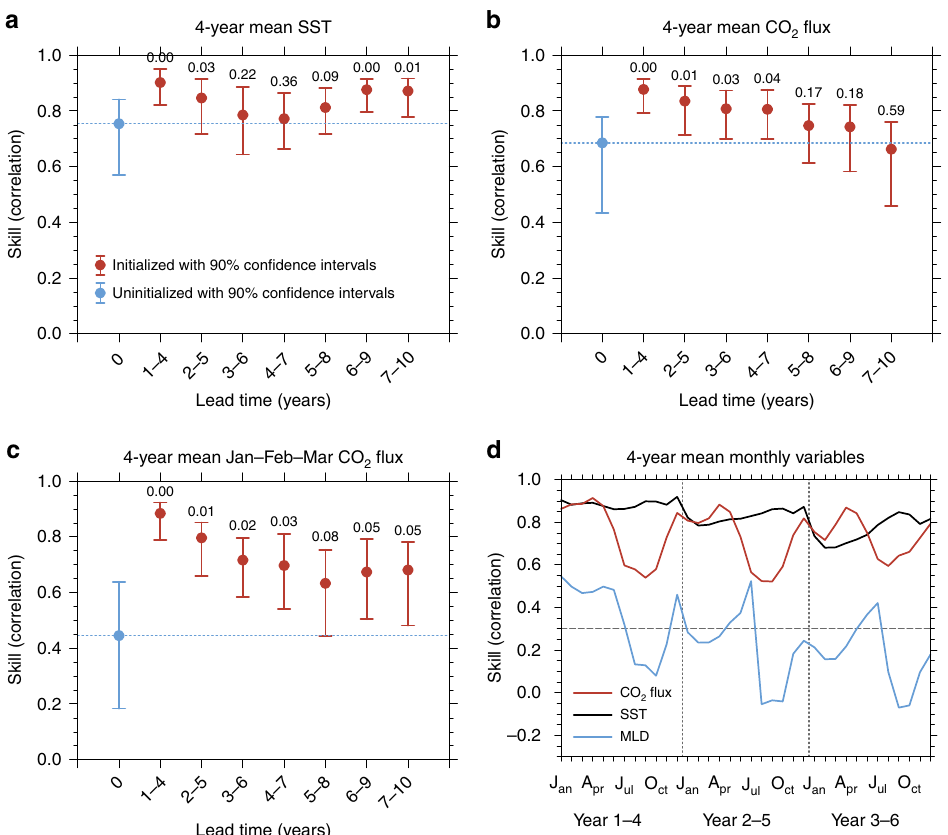
Figure 3 | Potential predictive skill of CO 2 flux and related physical variables. Correlation skill of ensemble mean of 4-year mean SST ( a ), 4-year mean CO 2 flux into the ocean ( b ), seasonally stratified 4-year mean CO 2 flux into the ocean (late winter, that is, January–February–March) ( c ) and monthly stratified 4-year mean CO 2 flux, SST and MLD ( d ) in the western SPG region. Shown are uninitialized (blue dot in a – c ) and initialized (red dots in a – c ) simulations at different lead time verified against assimilation. The correlations are calculated from 4-year mean predictions (that is, years 1–4, 2–5 and so on) of initialized simulations, and 4-year running mean of the corresponding assimilation and uninitialized time series. To ensure that the number of validation years is the same for both initialized and uninitialized simulations, we use the common time period from 1967–1970 mean to 2008–2011 mean. The blue dashed line in a – c extends the uninitialized correlation for easy comparison. The vertical lines in a – c provide 90% confidence intervals based on a bootstrap approach 46 . The numbers on the top of the bars in a – c show the P values based on the hypothesis that the difference of correlations between the initialized and uninitialized simulations is smaller or equal to zero based on 1,000 bootstrapped resamples. The potential predictive skills of monthly stratified 4-year mean CO 2 flux, SSTand MLD in d are shown with red, black and blue curves, respectively. Three-month running mean is applied before monthly correlation estimation in d . The horizontal dashed grey line in d shows the 95% level of significance based on a two-sided t -test. The vertical dashed grey lines in d are added to better distinguish different lead year